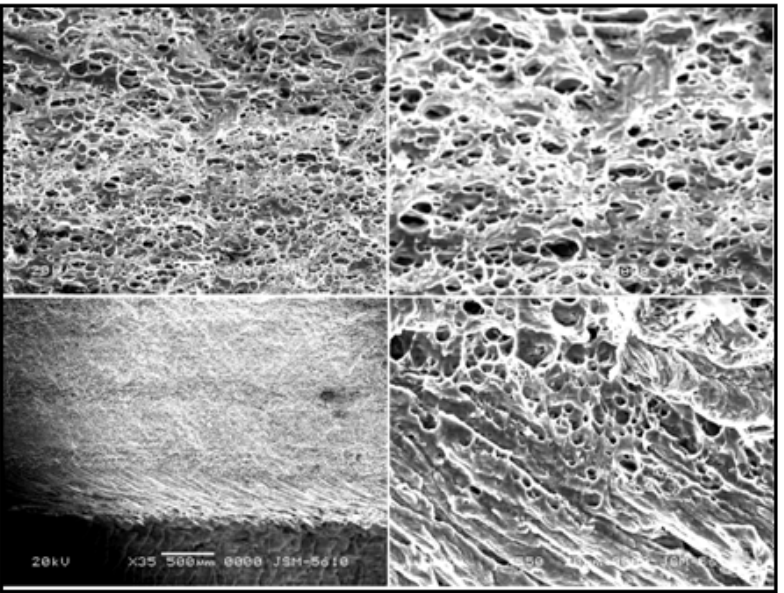
Figure 10: SEM images of tensile fracture surface of 6061-6082 at 62mm/min.